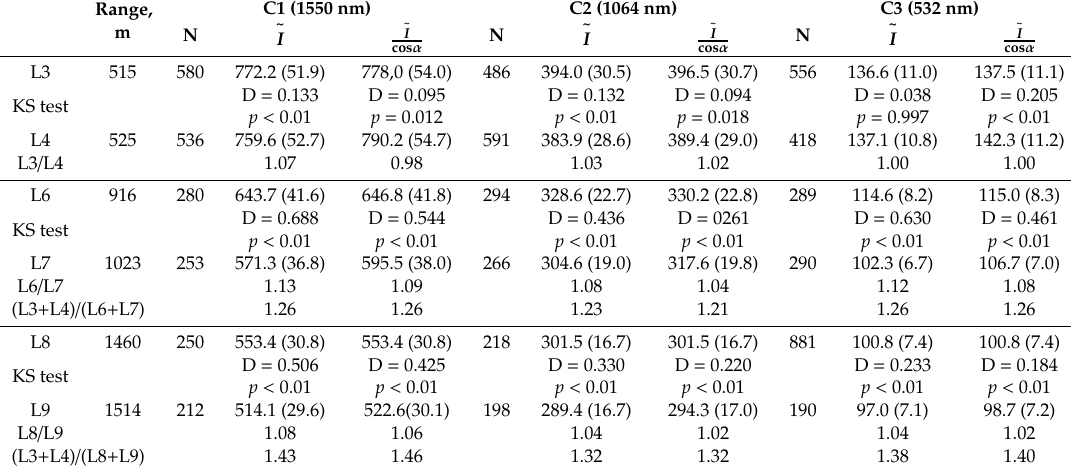
presented for all altitudes and channels and compared to single channel ratios for di ff erent altitudes.